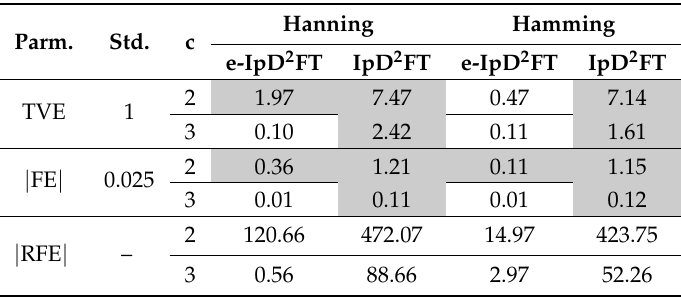
Table 4. Maximum TVEs (%), | FE | s (Hz) and | RFE | s (Hz/s) returned by the e-IpD 2 FT and IpD 2 FT in the “frequency deviation + second harmonic” test. Gray cells refer to the results beyond the boundaries of the M-class requirements of the standard.